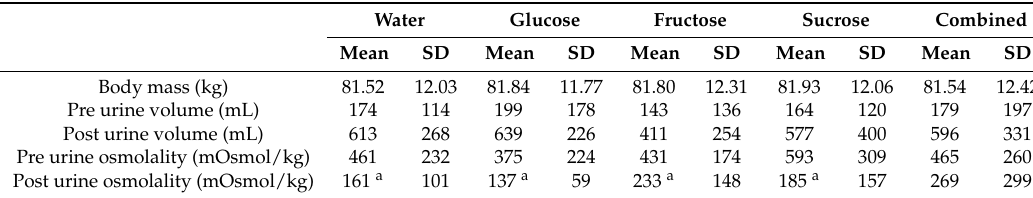
Table 1. Pre-trial body mass and urine characteristics pre- and